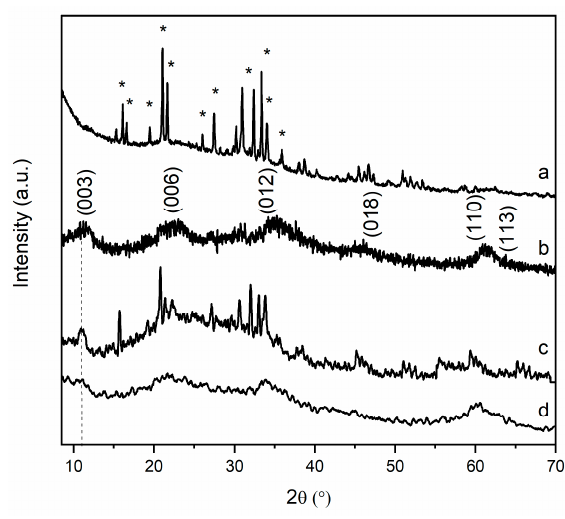
Figure 7. PXRD data for MgAl 200 /K 2 HPO 4 after release time of 1 h (a) and 168 h (b), and MgFe 200 /K 2 HPO 4 after release time of 1 h (c) and 168 h (d). * K-struvite MgFe 200 /K 2 HPO 4 after release time of 1 h (c) and 168 h (d). * K-struvite.